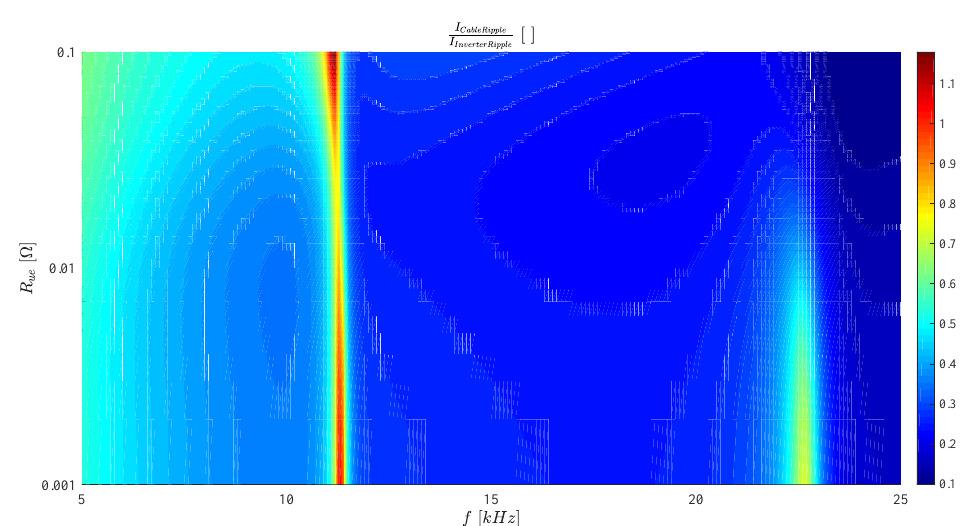
Figure 10. Simulated mapping of proportion of cable and inverter currents in the function of frequency and the shield grounding resistance.